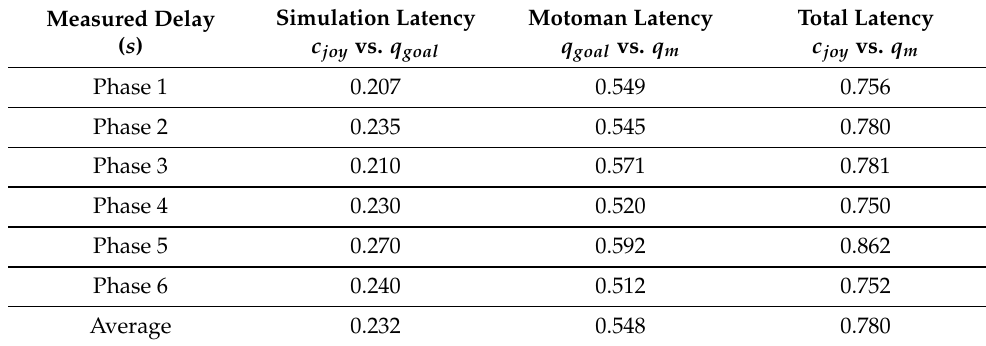
Figure 2. ( a ) First axis displacement while using the standard Motoman ROS node ( b ) Zoom on the 5th phase ( c ) Zoom on the 6th phase. Table 1. Measured latency while using standard control architecture: Average